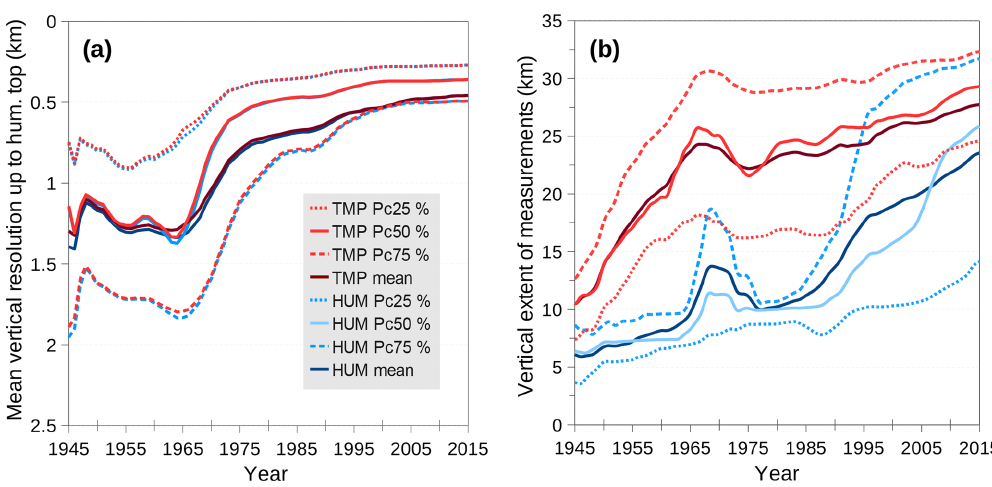
Figure 8. (a) Distribution of the “mean vertical resolution” (definition of Eq. 2) in the temperature (TMP) and humidity (HUM) observations across the globe, calculated up to the highest measuring level for humidity: mean and quartiles. (b) As in panel (a) , but for the vertical extent of TMP and HUM observations, restricted to observations with surface temperature data. All the curves are smoothed by a 5-year running